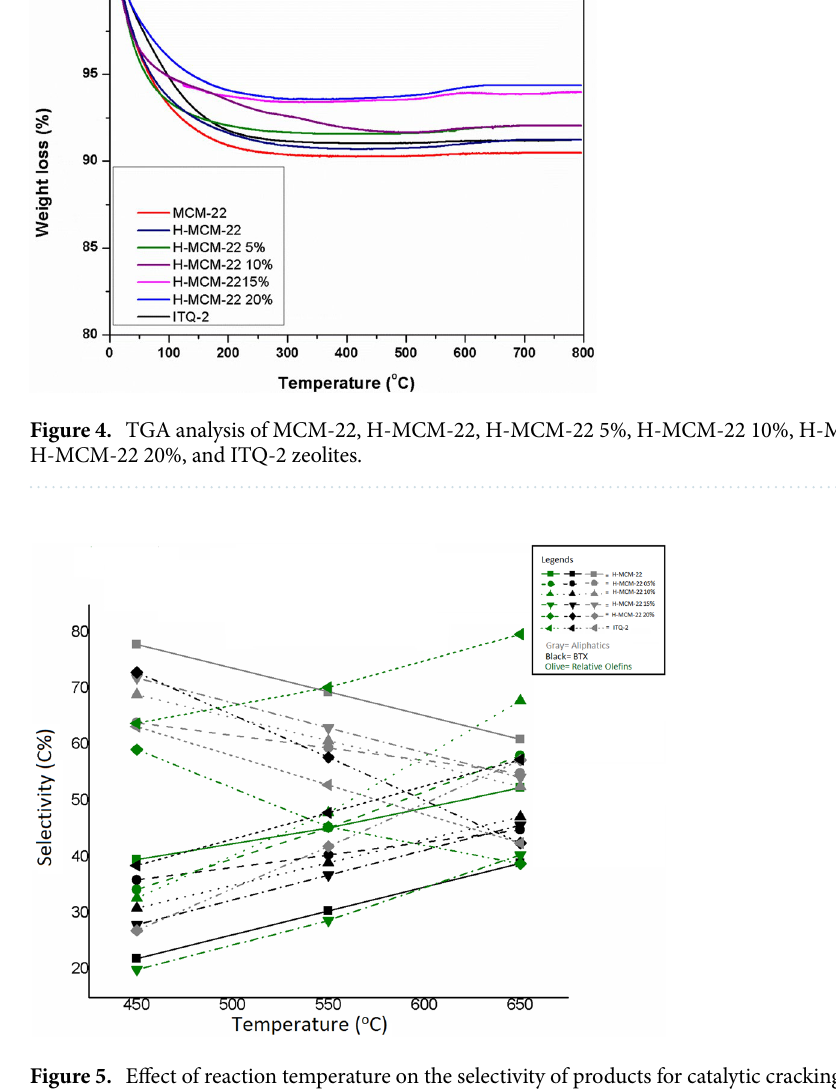
Relative Olefins = Olefins /( Olefins + Paraffins )